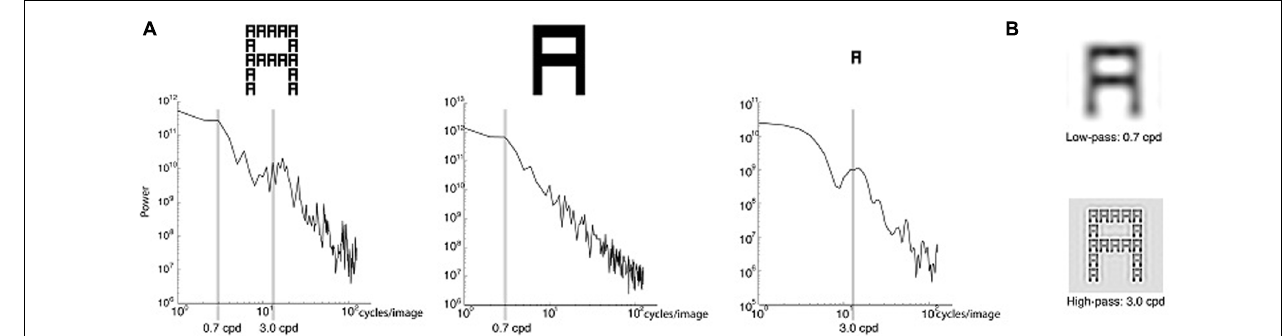
spectrum for a single letter the same size as the global letter in the Navon stimulus, constructed by filling in the local letters. The right plot shows the SF spectrum for a single local letter. (B) Navon displays spatially filtered to remove SFs above 0.7 cpd (top) and below 3 cpd (bottom).